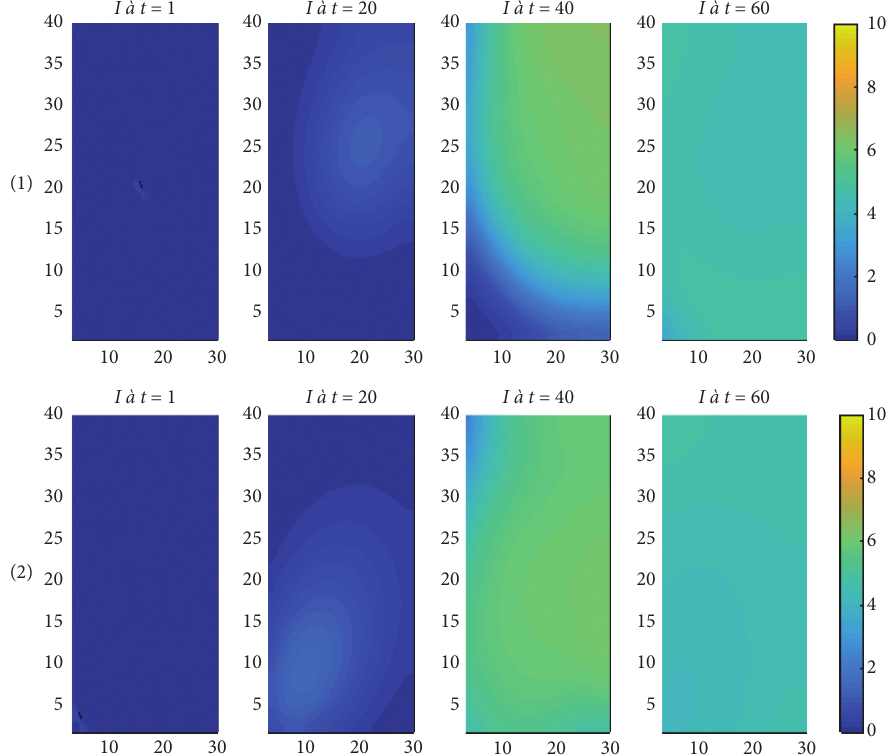
Figure 6: Infected behavior within Ω without control (vaccine strategy after 30